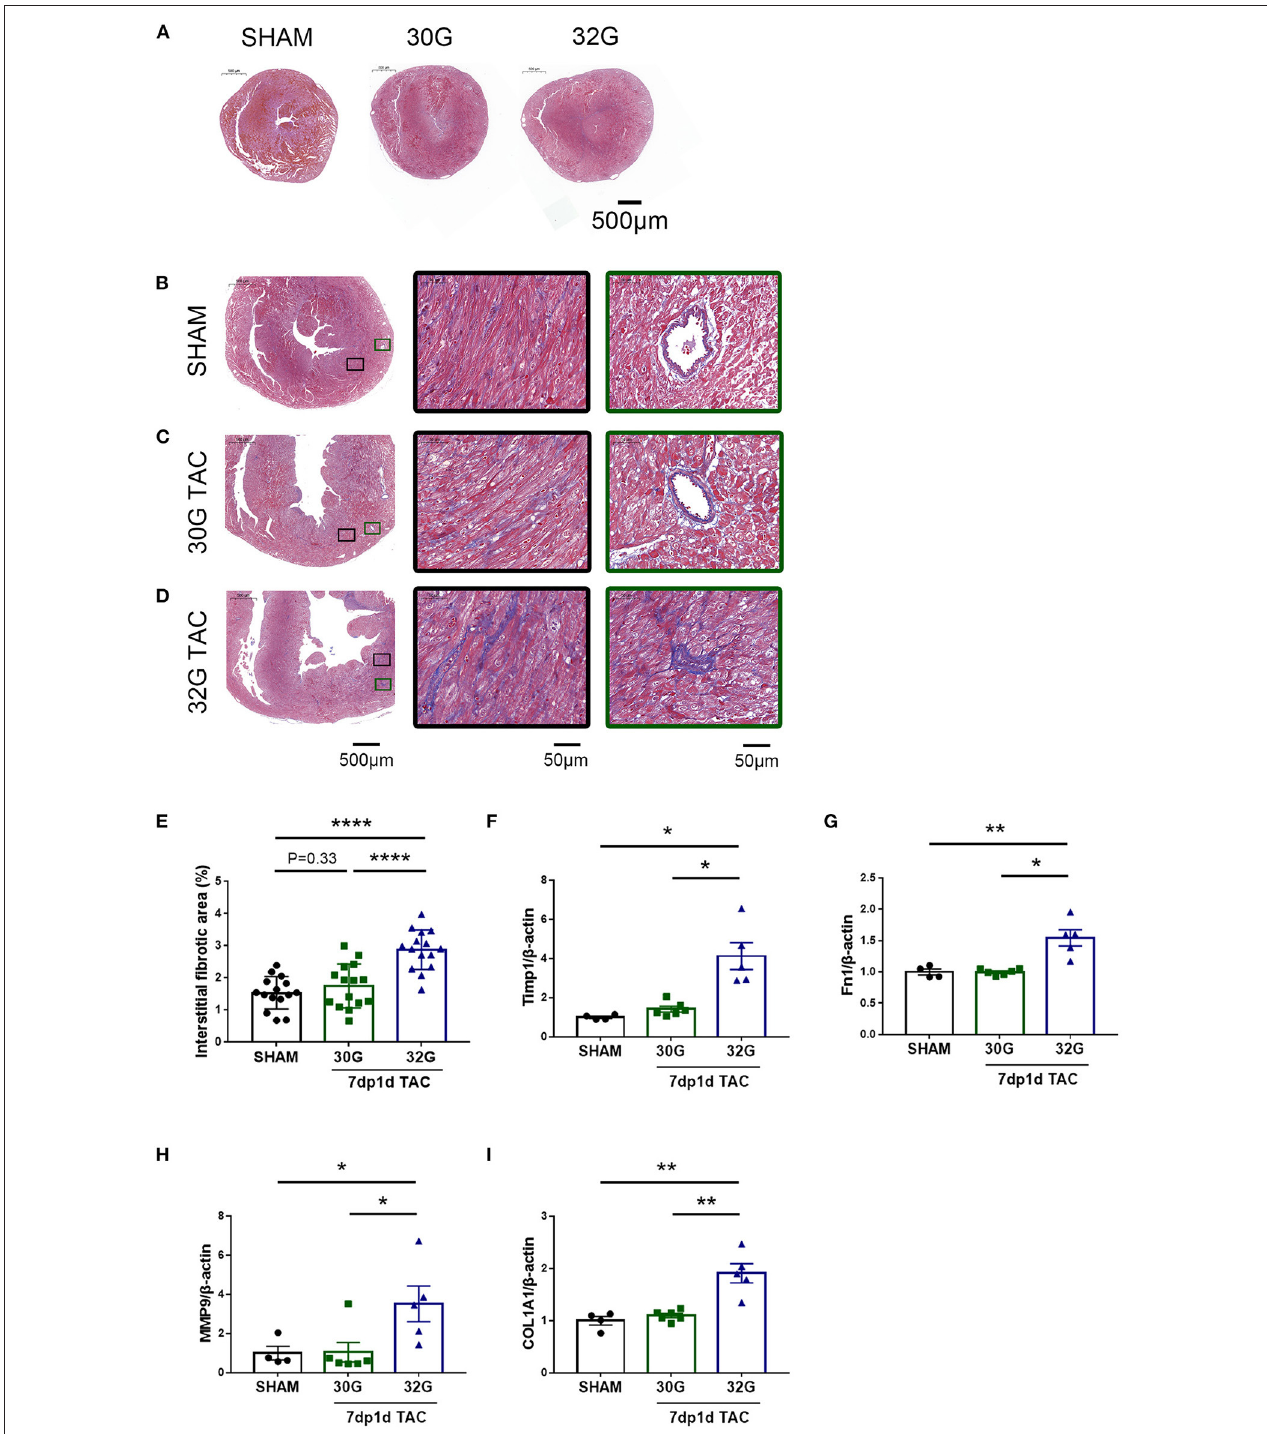
FIGURE 7 | Significantly increased fibrosis in the hearts of mice in the 32G TAC group 7 days after the surgery. (A) Masson staining of sham, 30G TAC, and 32G TAC mouse hearts. Scale bar: 500 µ m. (B–D) Representative Masson trichrome staining in the hearts of mice in the sham (B) , 30G TAC (C) , and 32G TAC (D) groups. The middle images are high-power fields of the corresponding left images (black square frame), showing interstitial fibrosis. The right images are high-power fields of the corresponding left images (green square frame) showing perivascular fibrosis. Scale bar: 500 µ m (left images); scale bar: 50 µ m (middle and right images). (E) Interstitial fibrosis in the three groups; n = 3 hearts per group. Each heart slide was random selected with five high-power fields for statistical